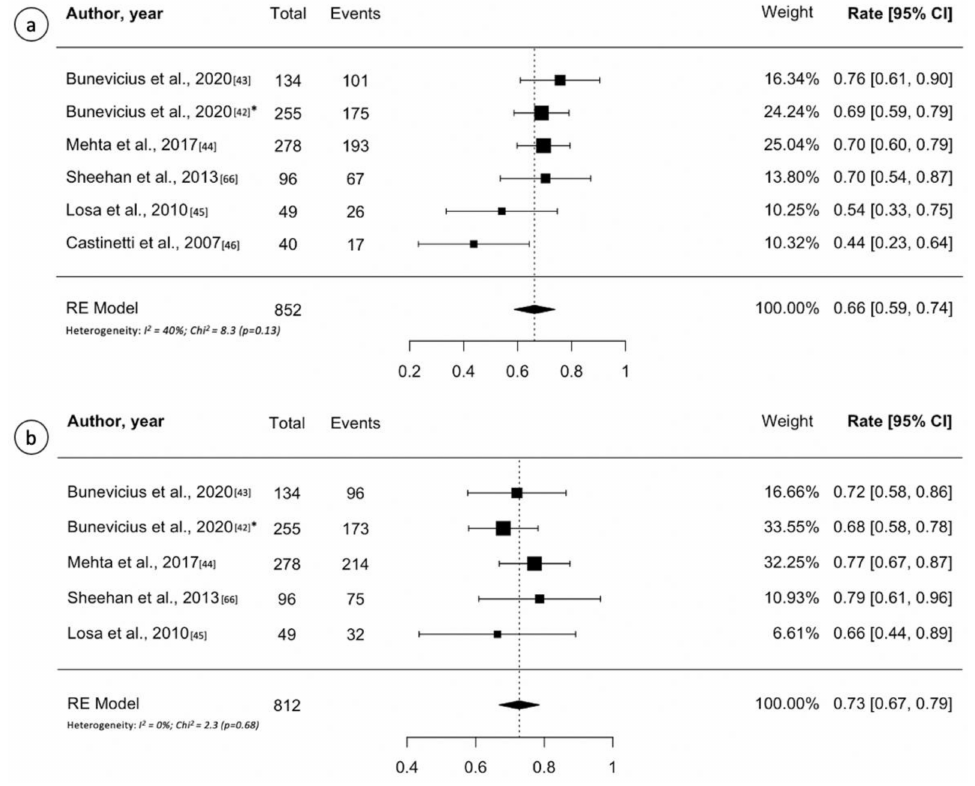
Figure 4. ( a ) Forest plot of overall tumor control following Gamma Knife treatment for adrenocorti- cotropic hormone-secreting pituitary adenomas; ( b ) Forest plot of 5-year recurrence-free survival after Gamma Knife treatment for adrenocorticotropic hormone-secreting pituitary adenomas. Random effects models pooled estimates are presented and heterogeneity analysis are included. * Multicen- ter